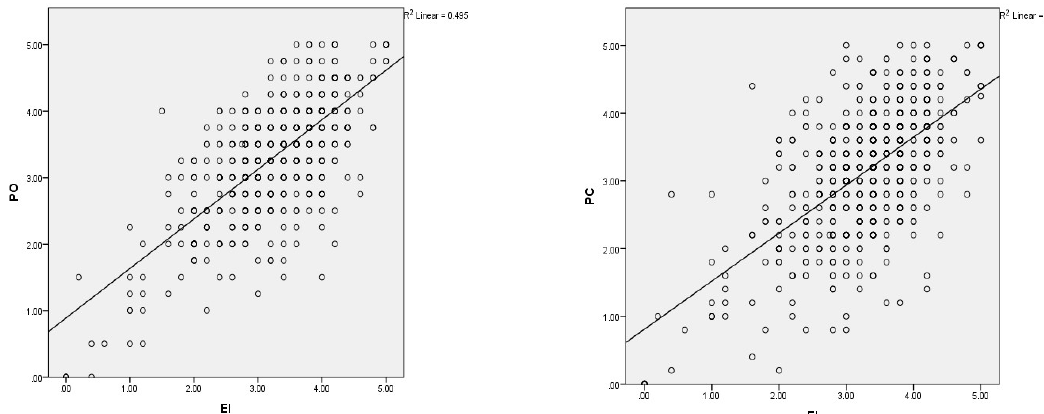
Fig. 3. Scatterplot for perceived opportunities (PO), perceived capacities (PC) and entrepreneurial inten- tion